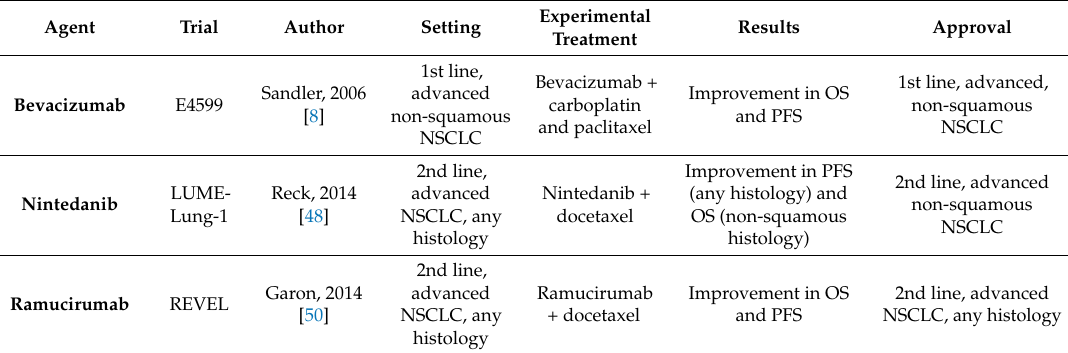
Table 4. Efficacy results from main phase III clinical studies with angiogenesis inhibitors in